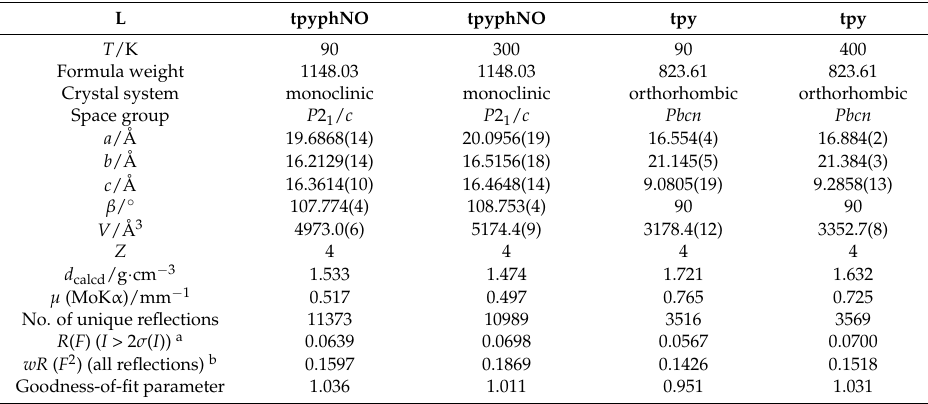
Table 1. Selected crystallographic parameters of [Co(L) 2 ](CF 3 SO 3 ) 2 (L = tpyphNO, tpy).